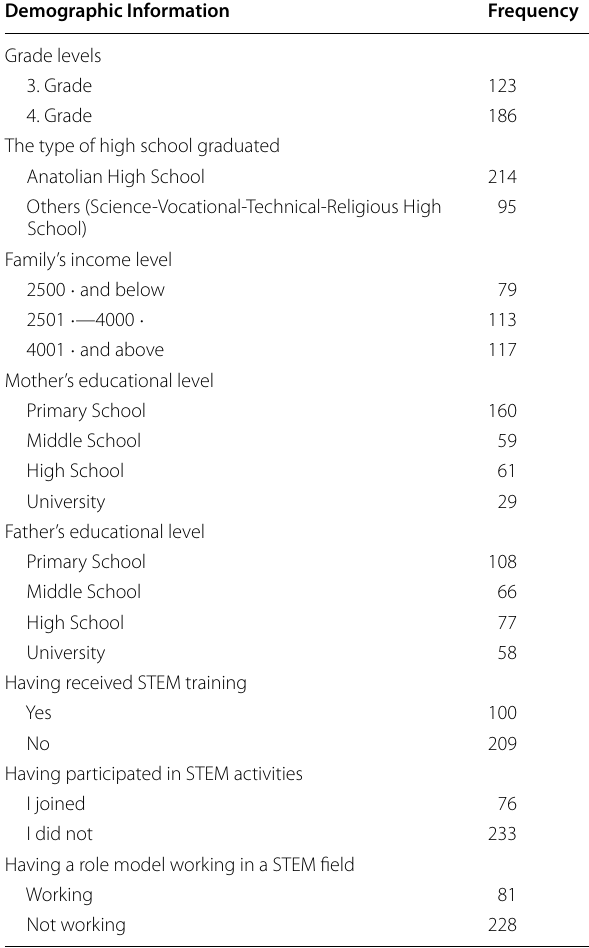
Table 1 Demographic distribution of the students